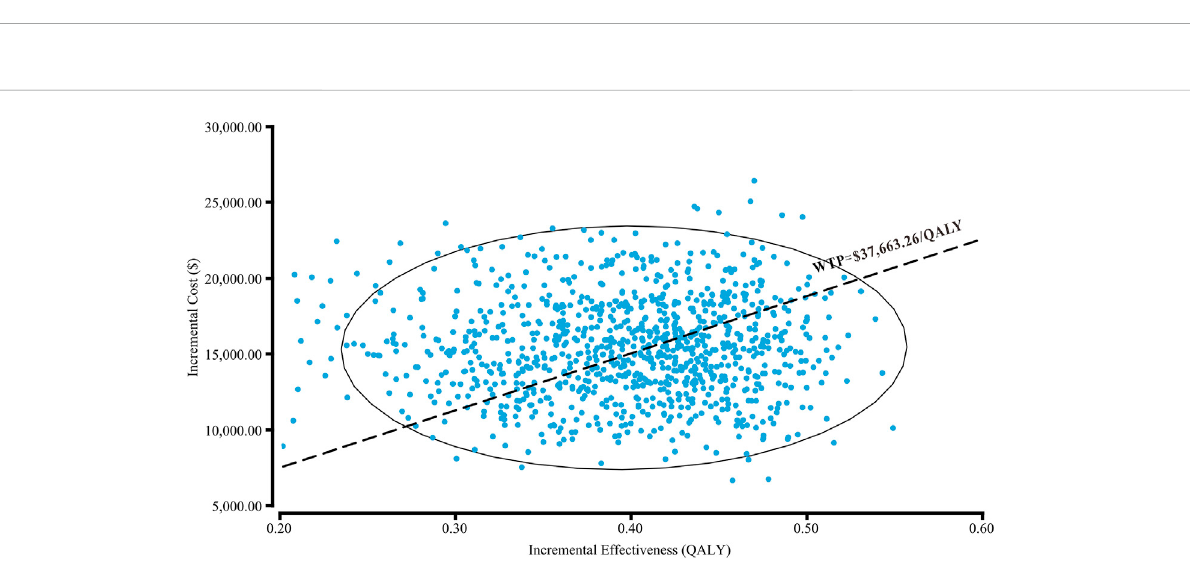
FIGURE 5 Probabilistic scatter plot of the ICER between osimertinib and the comparator EGFR-TKI. Each dot represents the ICER for one simulation. An ellipse means 95% con fi dence interval. Dots that are located below the ICER threshold represent cost-effective simulations. Abbreviations: WTP, willingness-to-pay; QALY, quality-adjusted